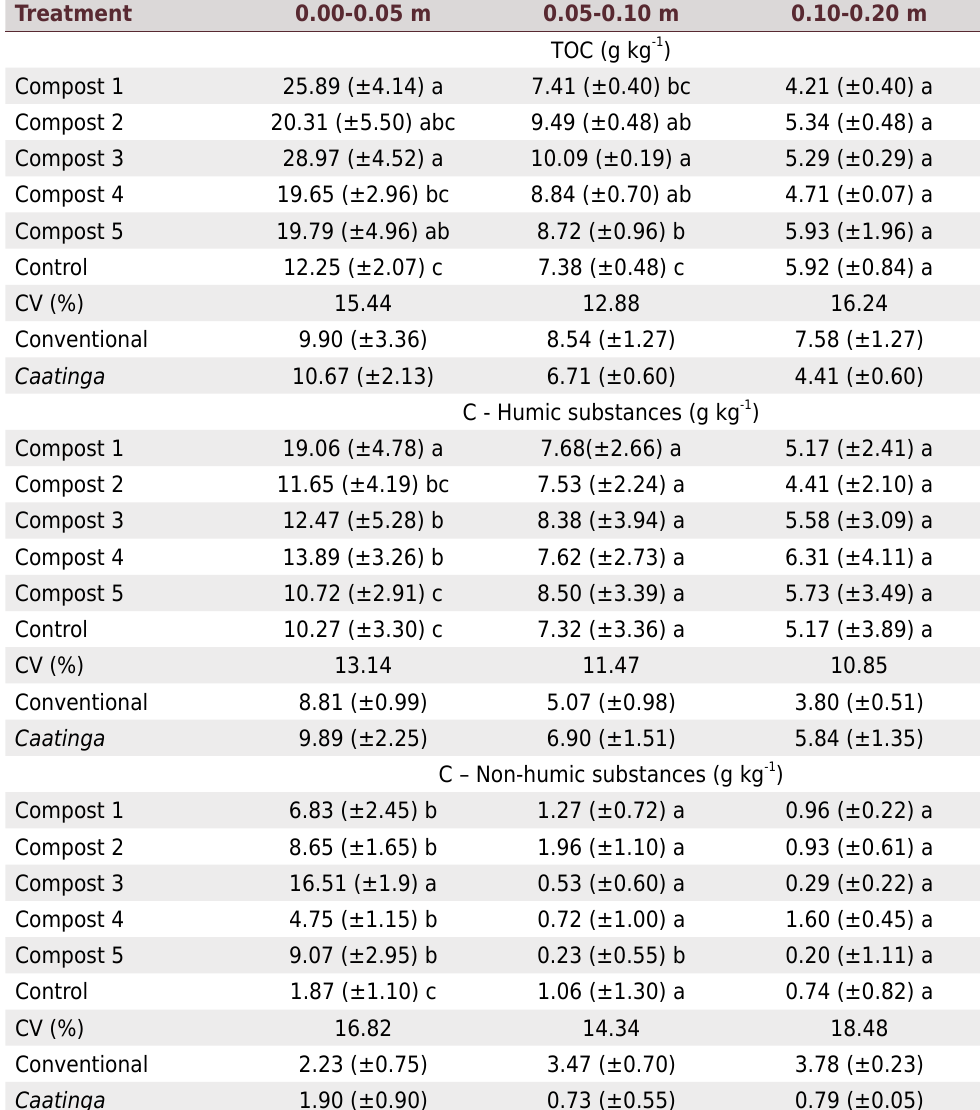
Table 3. Total Organic Carbon (TOC), carbon in humic substances (HS) and non-humic substances (NHS) of soil fertilized with organic composts and of reference areas